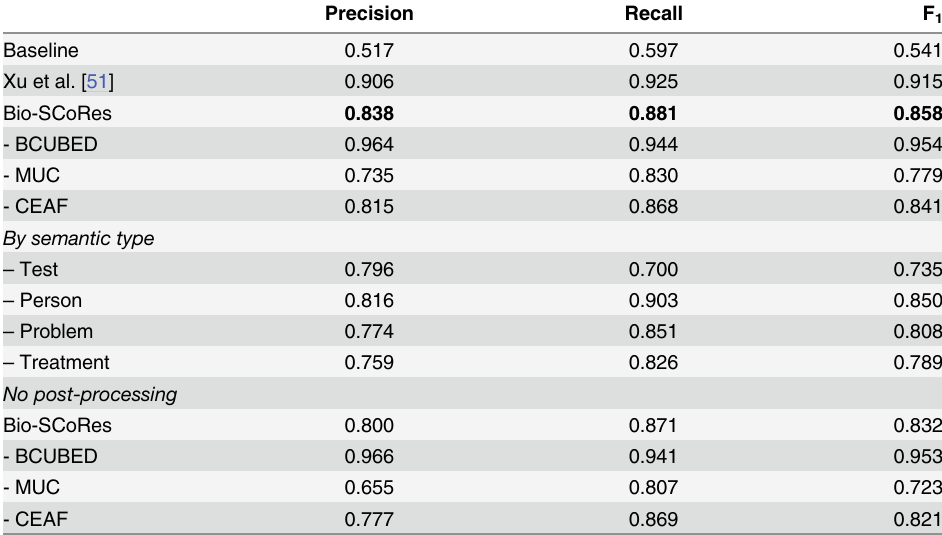
Table 13. Evaluation results on the test portion of the i2b2/VA